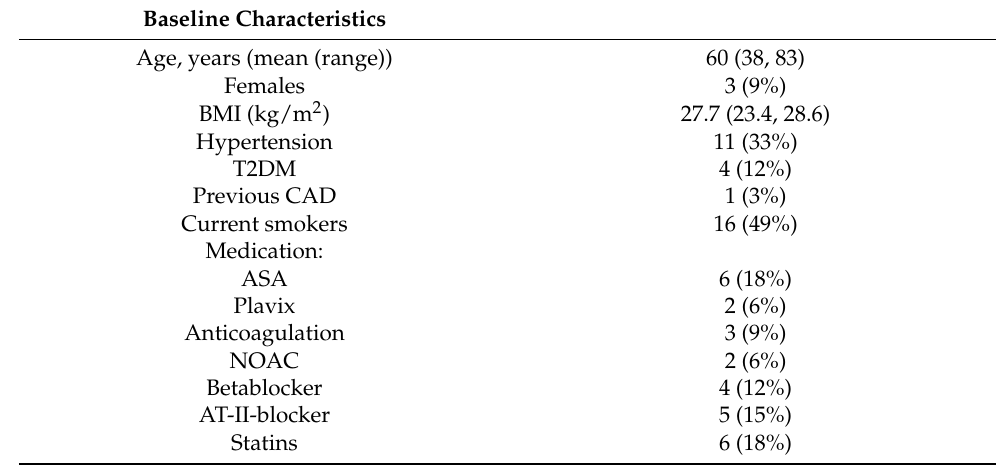
Table 1. Baseline characteristics of the total study population (n = 33). Data are presented as absolute numbers (%) or medians (25th, 75th percentiles) if not otherwise